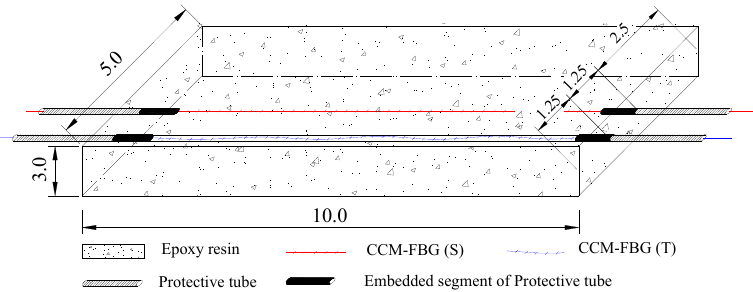
Figure 4. Schematic of the structure of CCM-FBG.